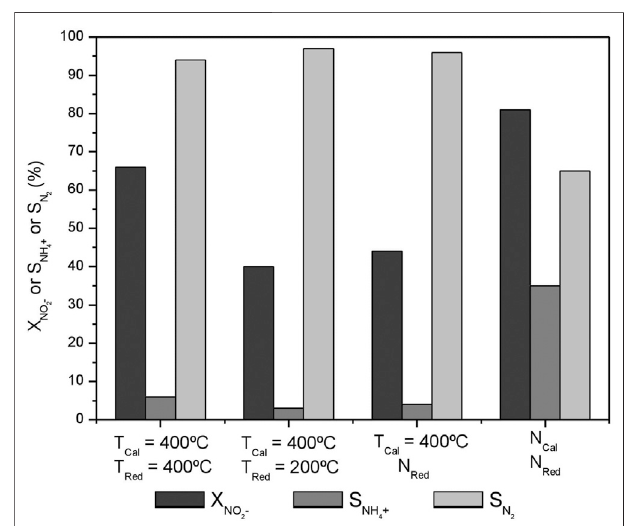
FIGURE 6 | NO 2 − conversion, NH 4+ and N 2 selectivities after 300 min of reactiononthe activated carbon-supported 1%Pt-1%In catalyst calcined and reduced at different